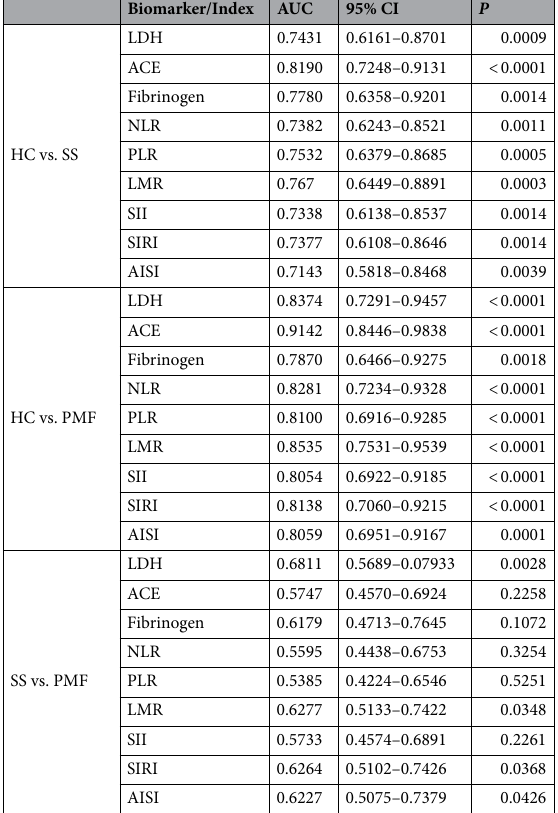
Table 3. AUC data from single biochemical marker/systemic inflammation index ROC curves. AUC, area under the ROC curve; 95% CI, 95% confidence interval; LDH lactate dehydrogenase; ACE angiotensin convertase enzyme; NLR (neutrophil/lymphocyte ratio), PLR (platelet/lymphocyte ratio), LMR (lymphocyte/ monocyte ratio), SII (neutrophil x platelet/lymphocyte ratio), SIRI (neutrophil x monocyte/lymphocyte ratio) and AISI (neutrophil x monocyte x platelet/lymphocyte ratio). 95% CI, 95% confidence interval; P , p